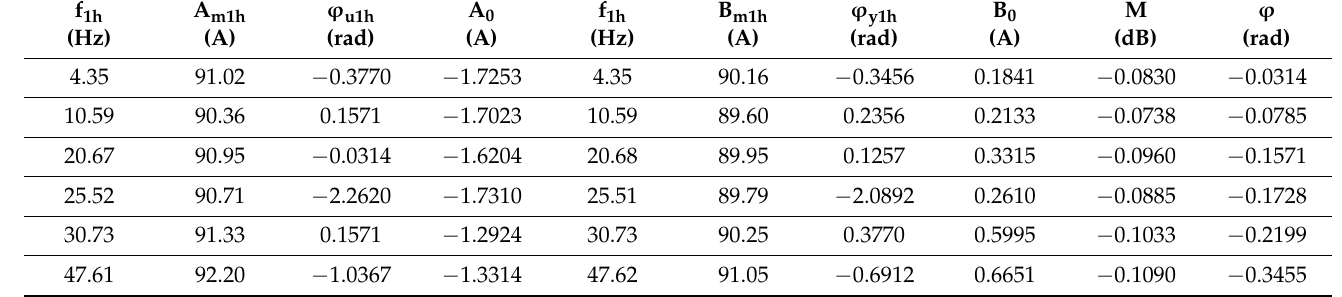
Table 2. Estimated parameters of the fundamental harmonic of the measurement signal of the motor’s stator current at the input and output of the analog filter and the values determined in accordance with the Formulas (4) and (5). f 1h (Hz)